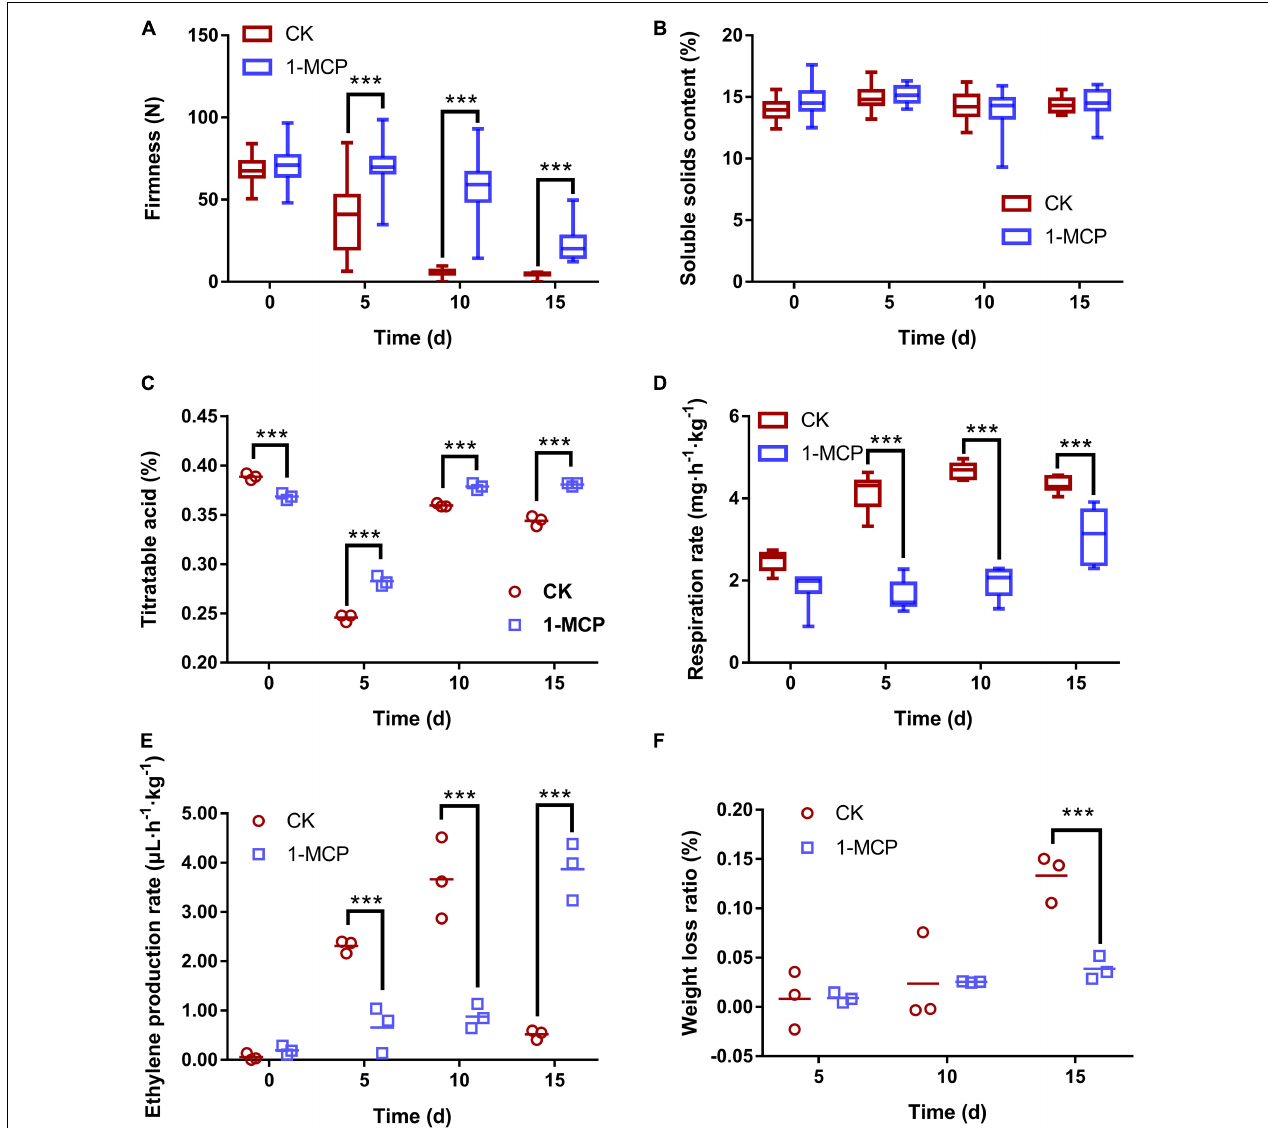
FIGURE 5 | Changes in pear ( Pyrus communis L.cv. “Doyenne du Comice”) fruit in firmness (A) , soluble solids content (B) , titratable acidity (TA) (C) , respiration rate (D) , ethylene production rate (E) , and weight loss ratio (F) with/without 1-MCP treatment. The asterisk denotes the significance of difference among treatments (*** p <